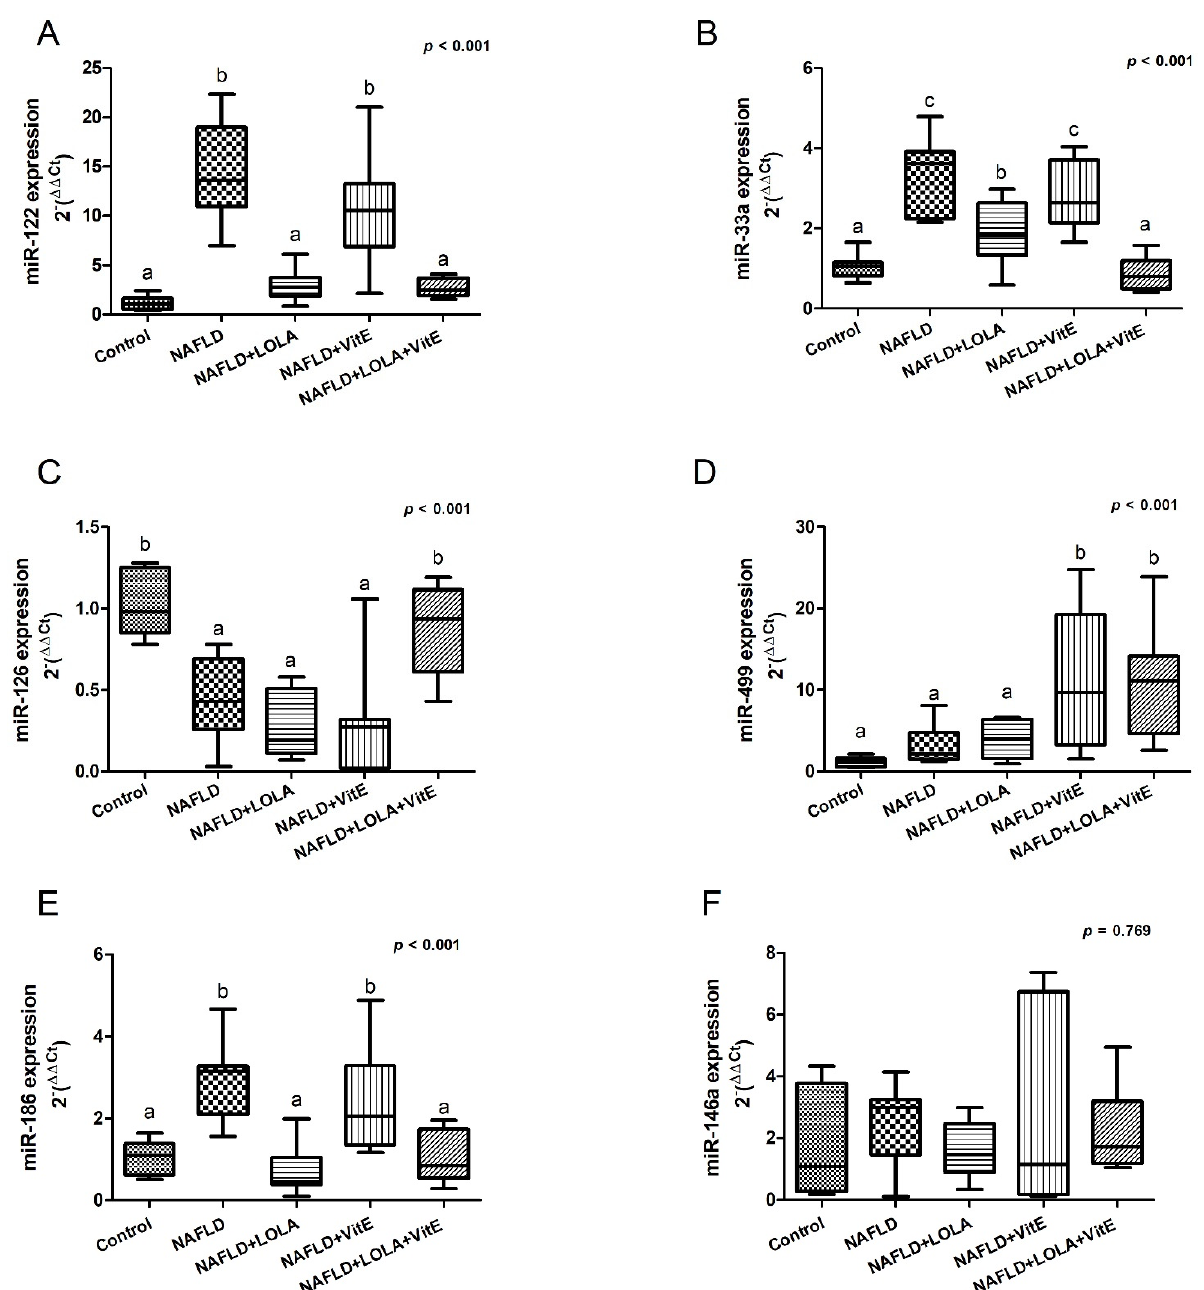
Figure 3. Gene expression of the circulating microRNAs. ( A ) miR-122, ( B ) miR-33a, ( C ) miR-126, ( D ) miR-499, ( E ) miR-186, and ( F ) miR-146a. Data expressed as median (25th–75th percentile), Kruskal–Wallis test. Different letters indicate a significant difference between groups ( p < 0.05). LOLA: ornithine aspartate; NAFLD: nonalcoholic fatty liver disease, and VitE: vitamin E. There was a significant increase in the gene expression of miR-122 in animals in the NAFLD group compared with the control group ( p < 0.001). NAFLD+LOLA+VitE and NAFLD+LOLA groups showed a significant reduction in the expression of this marker in relation to the NAFLD ( p < 0.001, in both) and NAFLD+VitE ( p < 0.001, in both)